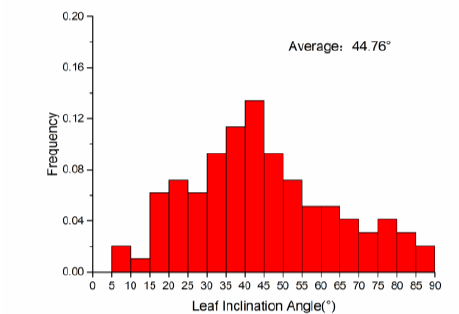
Figure 9. Photo acquisition using MDI instrument